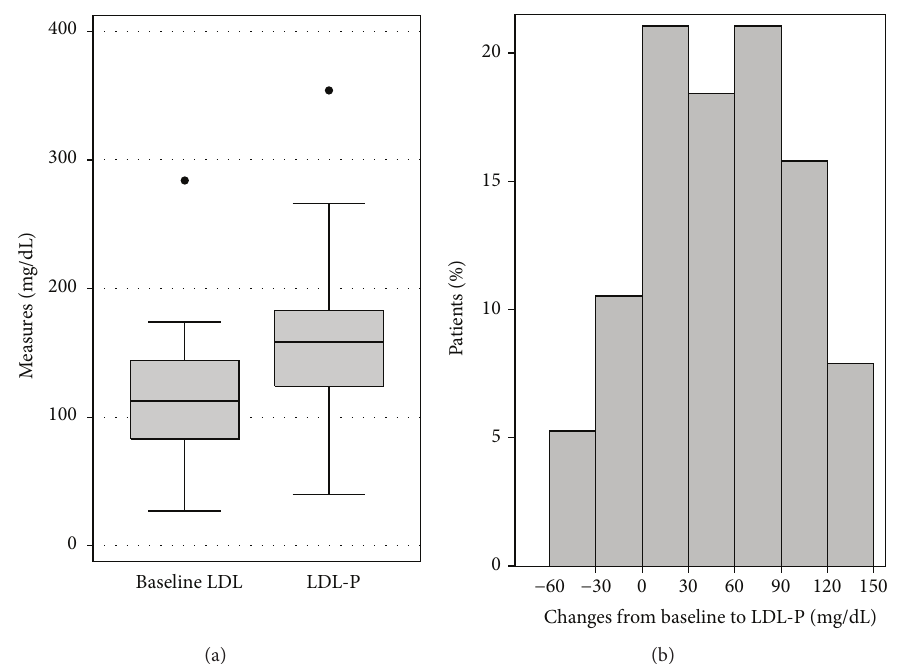
Figure 3: (a) Box plot illustrating LDL-c level at baseline (baseline LDL) and the peak LDL-c during mitotane therapy (LDL-P). Mean LDL- base was 114.4mg/dL and mean LDL-P was 160.1mg/dL ( 𝑃 < 0.001 ). (b) A histogram showing the distribution of within-patient LDL-c changes.